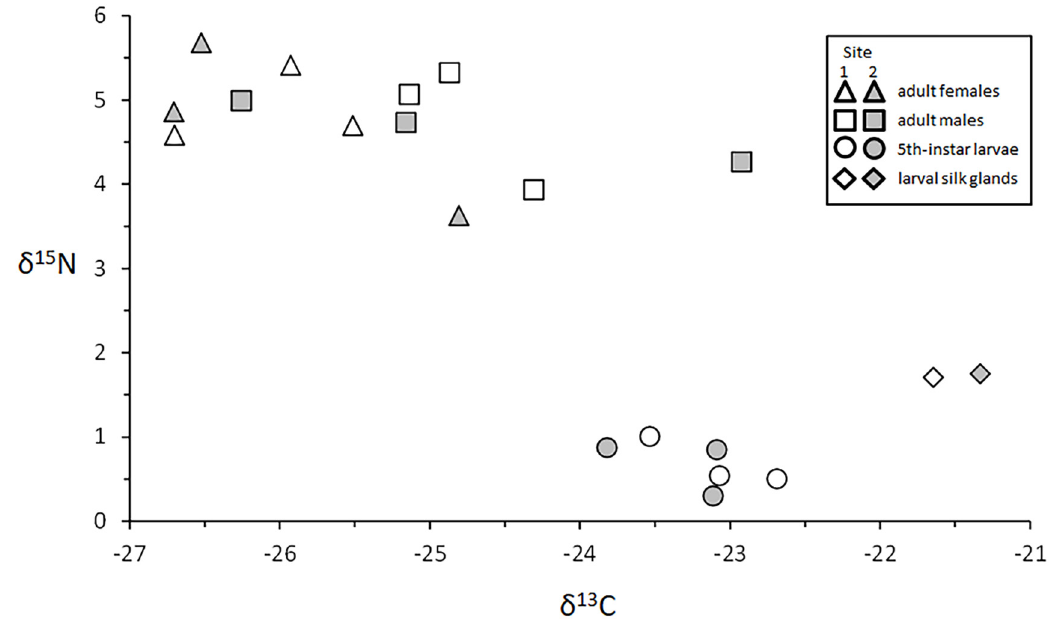
Figure 14. δ 13 C and δ 15 N data for male and female adults, 5th instar larvae, and 5th instar silk glands from Sites 1 and 2.